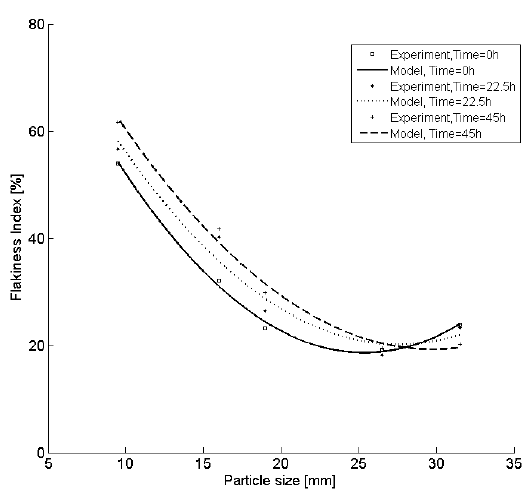
Figure 8. Worn liner causes the flakiness curve to change over time.